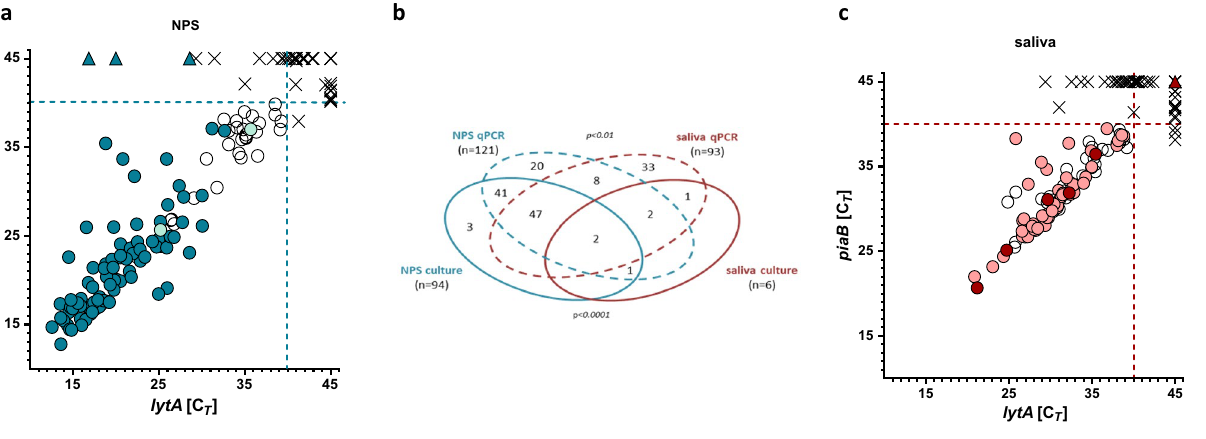
Figure 1. Detection of S treptococcus pneumoniae with molecular methods versus isolation of viablei pneumococci from nasopharyngeal (NPS) and saliva samples collected from 394 children. Left and right panels represent scatter plots of the lytA and piaB qPCR cycle threshold (C T ) values from ( a ) NPS and ( c ) saliva samples. Venn diagram in panel ( b ) depicts the numbers of NPS and saliva samples positive for pneumococci based on recovery of S. pneumoniae from a culture (solid-line ovals) or when tested with qPCRs (dashed-line ovals). Each symbol in panels ( a ) and ( c ) represents an individual sample. Samples with a C T for both piaB and lytA below 40 C T (marked with dashed lines) were considered positive for pneumococcus with molecular method. Dark-blue dots in panel ( a ), and dark-red dots in panel ( c ) represent NPS (n = 94) and saliva (n = 6) samples, respectively, from which pneumococci have been cultured. Light-blue dots in panel ( a ) (n = 2), and light-red dots in panel ( c ) (n = 52) represent samples positive for S. pneumoniae by molecular method, negative by culture yet with pneumococcus isolated from a paired sample (samples from culture-confirmed carriers). Open circles represent NPS (n = 28), and saliva (n = 41) samples classified with molecular method as positive for S. pneumoniae from children from whom no S. pneumoniae isolate has been cultured. Triangles represent NPS (n = 3) and saliva (n = 1) samples negative by molecular method, from which pneumococci have been cultured. Crosses represent NPS (n = 227), and saliva (n = 294) samples negative by any method used. The p -values reported in panel ( b ) were calculated with McNemar’s test.